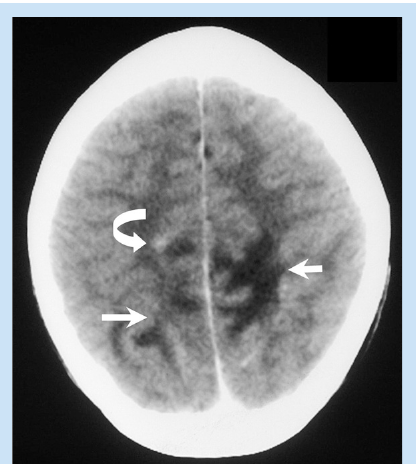
Fig. 2. Post-contrast CT scan of the brain demon- strates bilateral parafalcine areas of low density in the posterior parietal and occipital white matter (straight arrows). There is focal enhancement at the periphery (curved arrow).